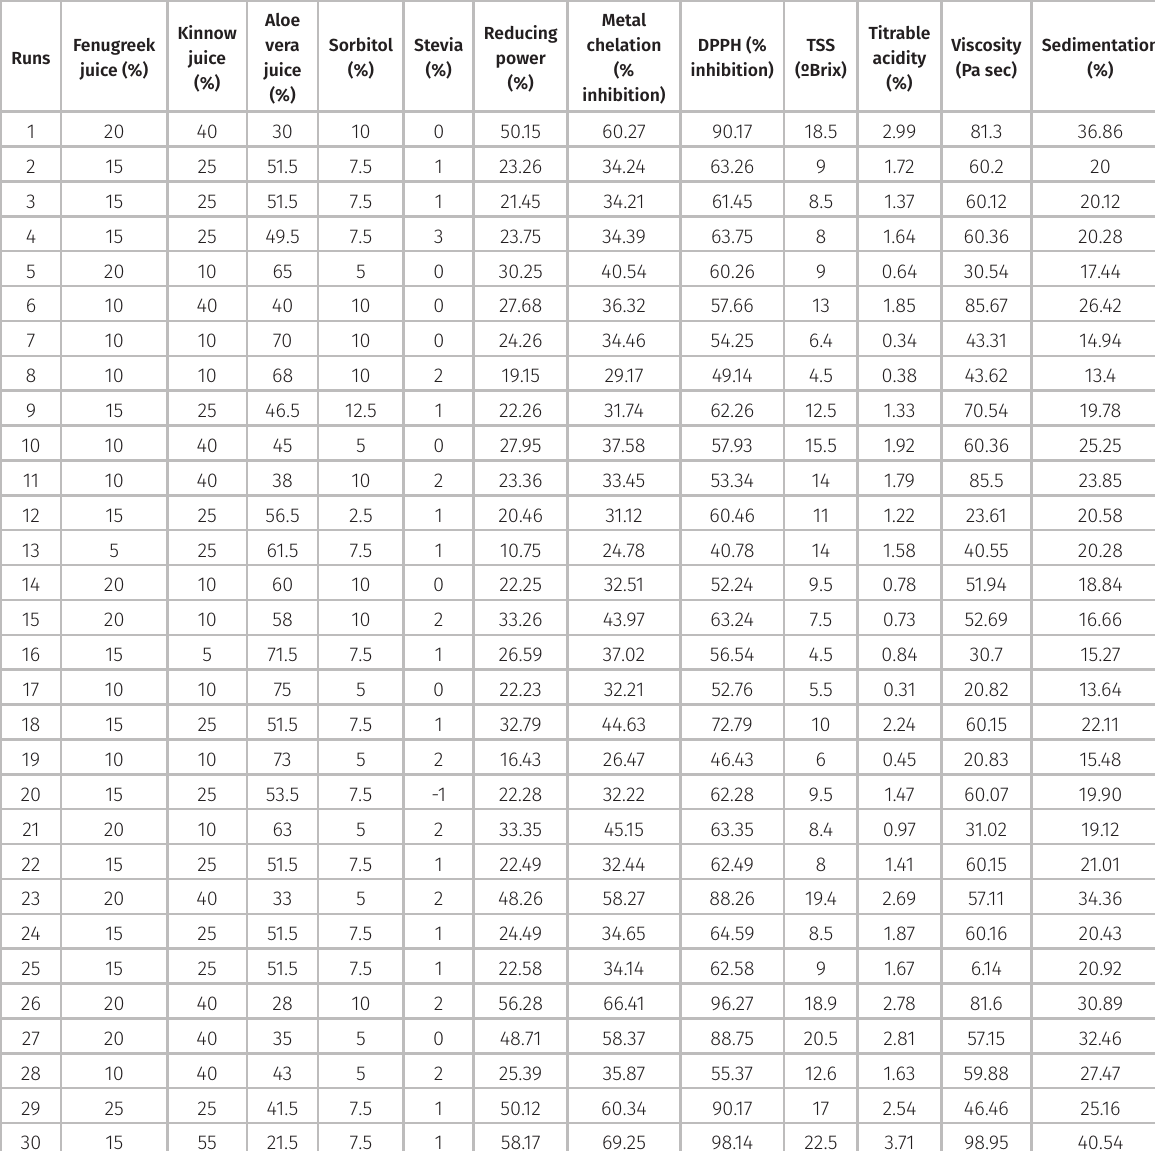
Table II. Physiochemical attributes of microgreen based functional juice in response surface methodology. Fenugreek Runs juice